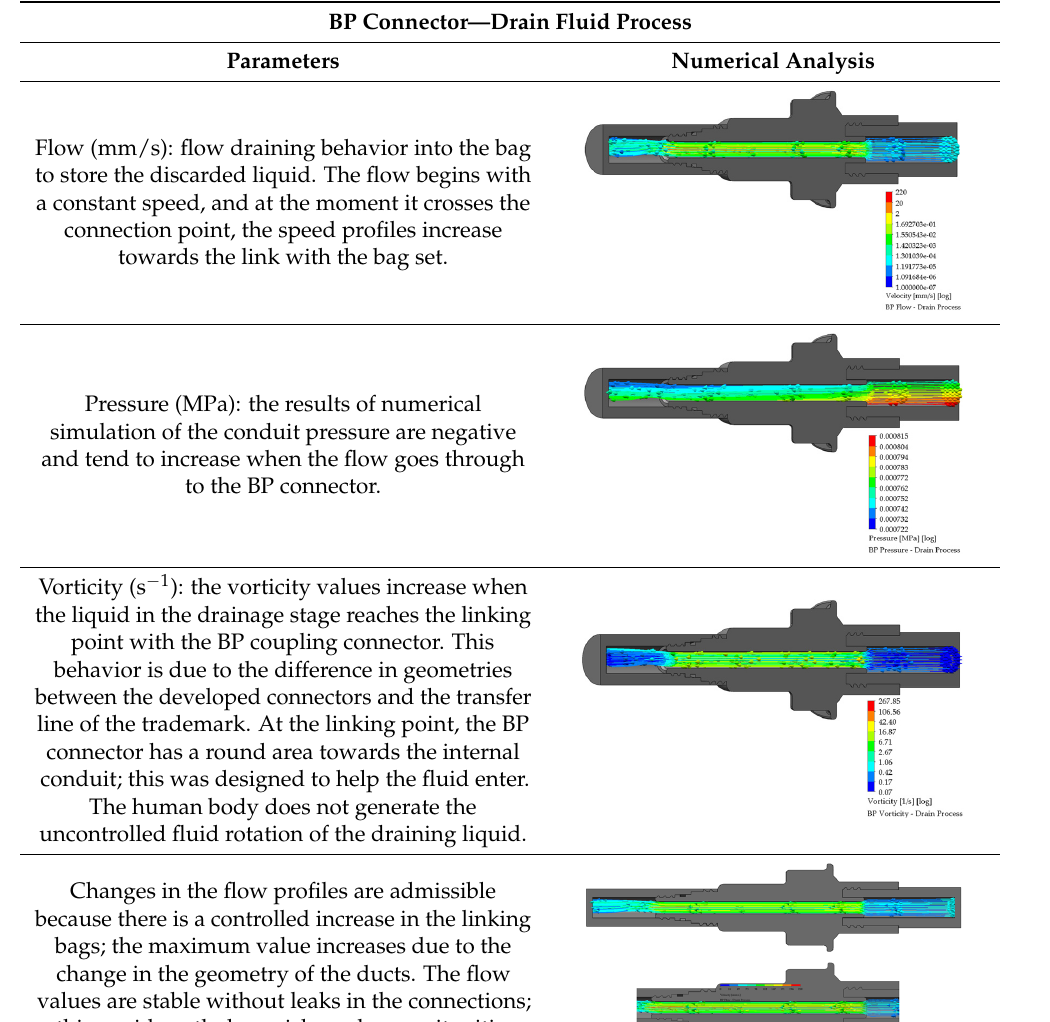
Table 5. Flow, pressure, and vorticity numerical analysis for PB connector—infusion fluid process. PB Connector—Infusion Fluid Process Parameters